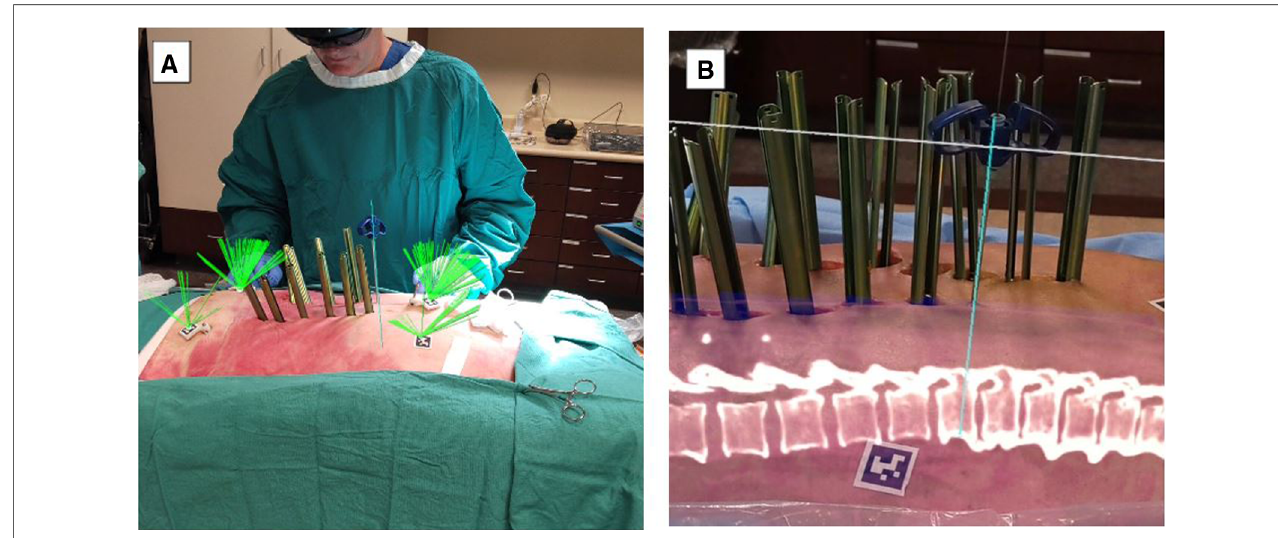
FIGURE 4 MISS navigation procedure utilizing VisAR technology. ( A ). The green ray (usually not seen) continuously monitors the centrum of each AprilTag for ongoing adjustment of the registration, if required. AprilTags are adhered to the skin and also placed on platforms stabilized by bone pins. The Jamshidi needle is aligned with the virtual needle/pathway and has been inserted percutaneously. ( B ). Lateral view of a MISS procedure in progress under VisAR navigation. Note the Jamshidi needle that has successfully penetrated the underlying pedicle. The center of the needle has been extracted, and a K-wire has been inserted for guidance of a cannulated screw. An optical fi ducial (AprilTag) appears below the vertebrae. MISS, minimally invasive spine surgery. Courtesy of